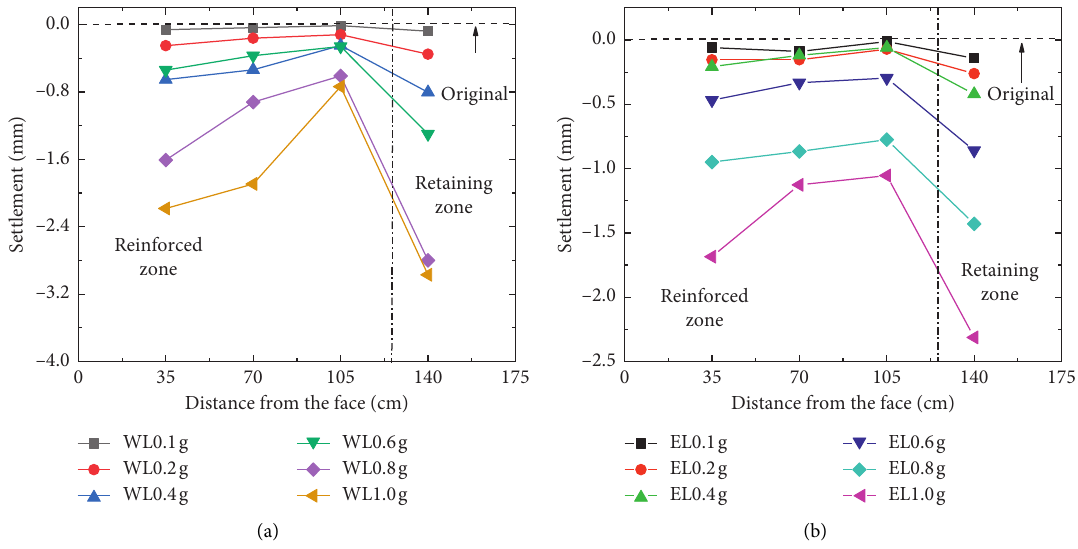
Figure 14: Settlement distributions of the specimen (scale factor: 1/4): (a) WL and (b) EL.